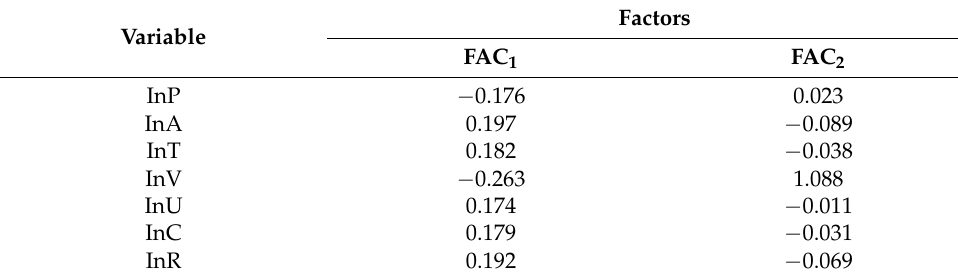
Table 7. Score coefficient matrix of principal component analysis.